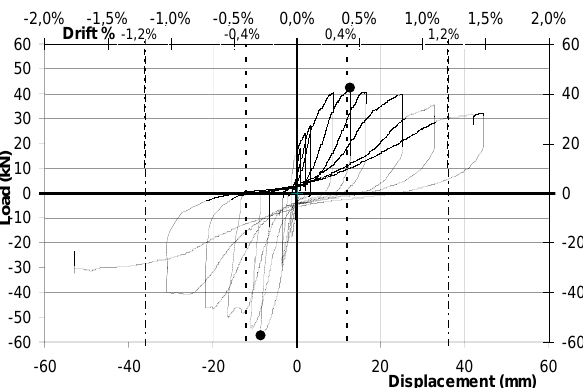
Figure 6 Load-top displacement hysteresis curve of reference infilled frame RISPS2 Fig. 6. Load-top displacement hysteresis curve of reference infilled frame